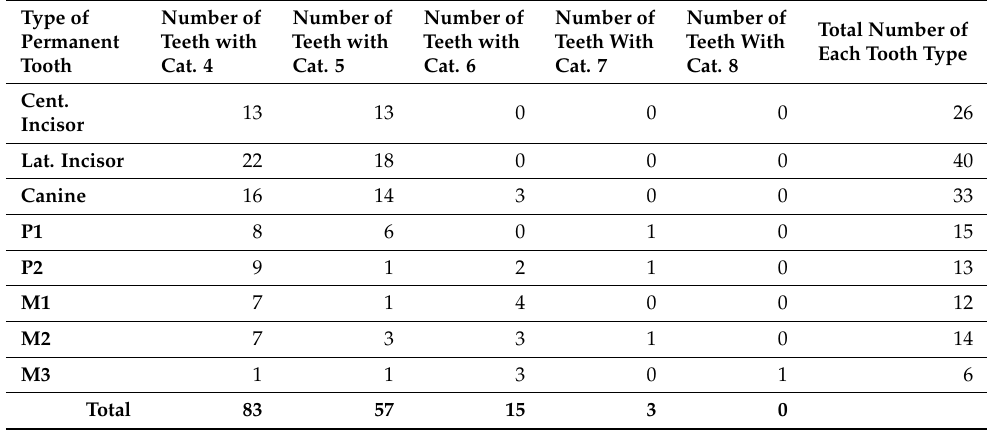
Table 2. The number of each tooth type for each category of tooth wear scored using Molnar’s system [29] for the permanent dentition of the adults from the St Mary’s sample, with the number of each tooth type for each category of tooth wear scored.